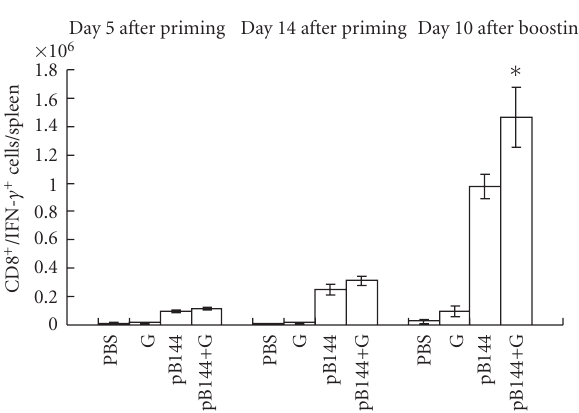
Figure 4: E ff ect of β -glu6 on the CD8 + /IFN - γ + T cells induced by pB144 in the spleen. Mice were immunized by pB144 with β -glu6, and boosted at day 30 after priming. At day 5 (left) and 14 (middle) after priming, and day 10 after boosting (right), splenocytes were isolated and cultured for 5 hours in the absence or in the presence of a specific peptide corresponding to K b -restricted CTL epitope of HBcAg. Cells were then double-stained with PerCP-anti-CD8a and APC-anti-IFN- γ antibodies and analyzed cytofluorimetrically. Data expressed as mean ± SD of 3 mice/group. ∗ P < . 05, pB144+G versus pB144 alone.